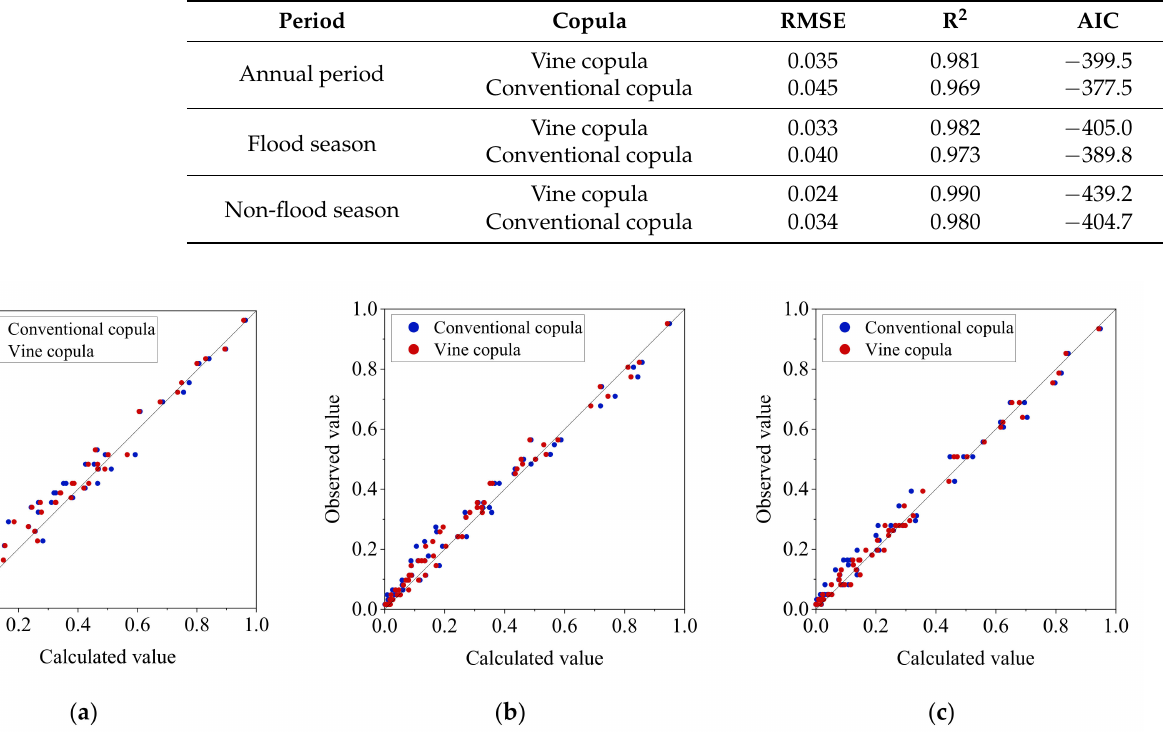
Figure 13. The P-P plots of the observed values and calculated values of the conventional copula function and the vine copula function at three scales: ( a ) is under the annual scale; ( b ) is in flood season; and ( c ) is in non-flood